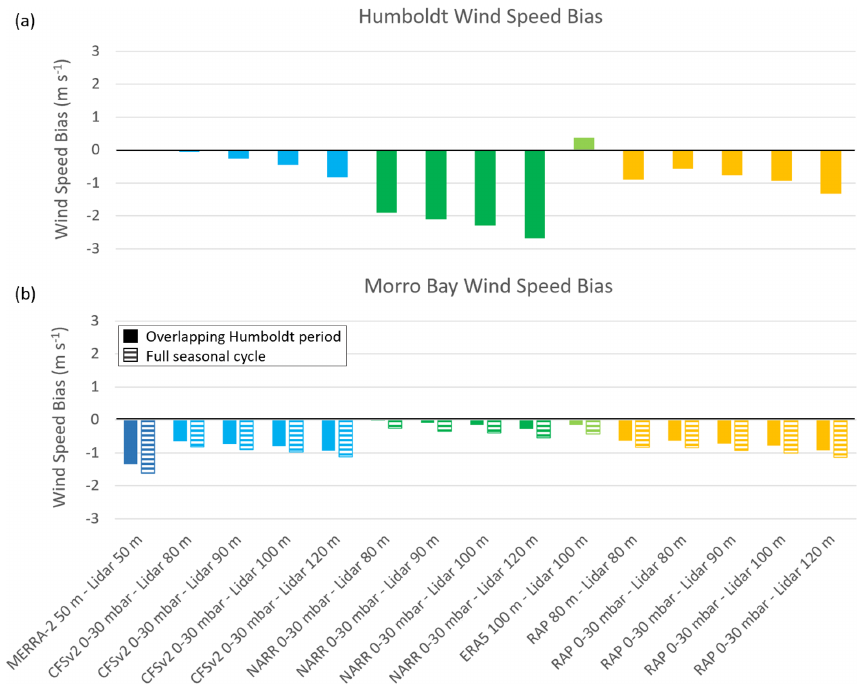
Figure 4. Wind speed biases during the (a) Humboldt and (b) Morro Bay deployments. The Morro Bay biases are provided for the over- lapping Humboldt recovery periods of 1 October 2020–27 December 2020 and 25 May 2021–30 September 2021 (solid) and for the entire Morro Bay collection period that covers a full seasonal cycle